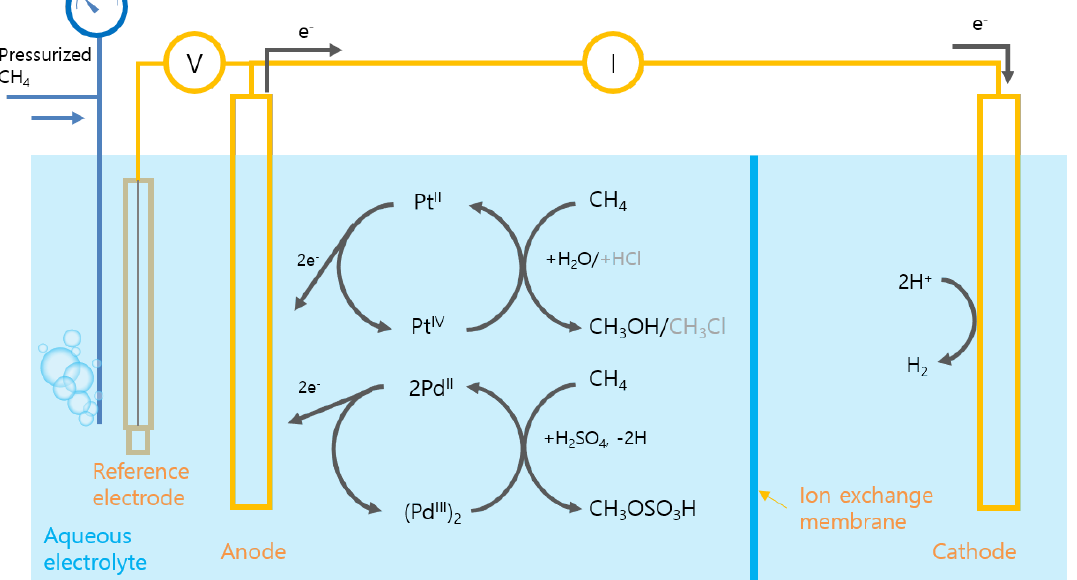
Figure 9. Schematic diagram of functionalization of methane with an electrochemical redox shuttle complex [29,30] .